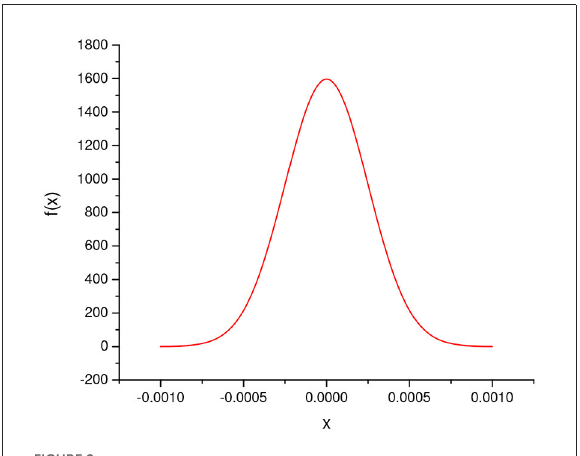
FIGURE2 The probability density function of Norm (0, 1